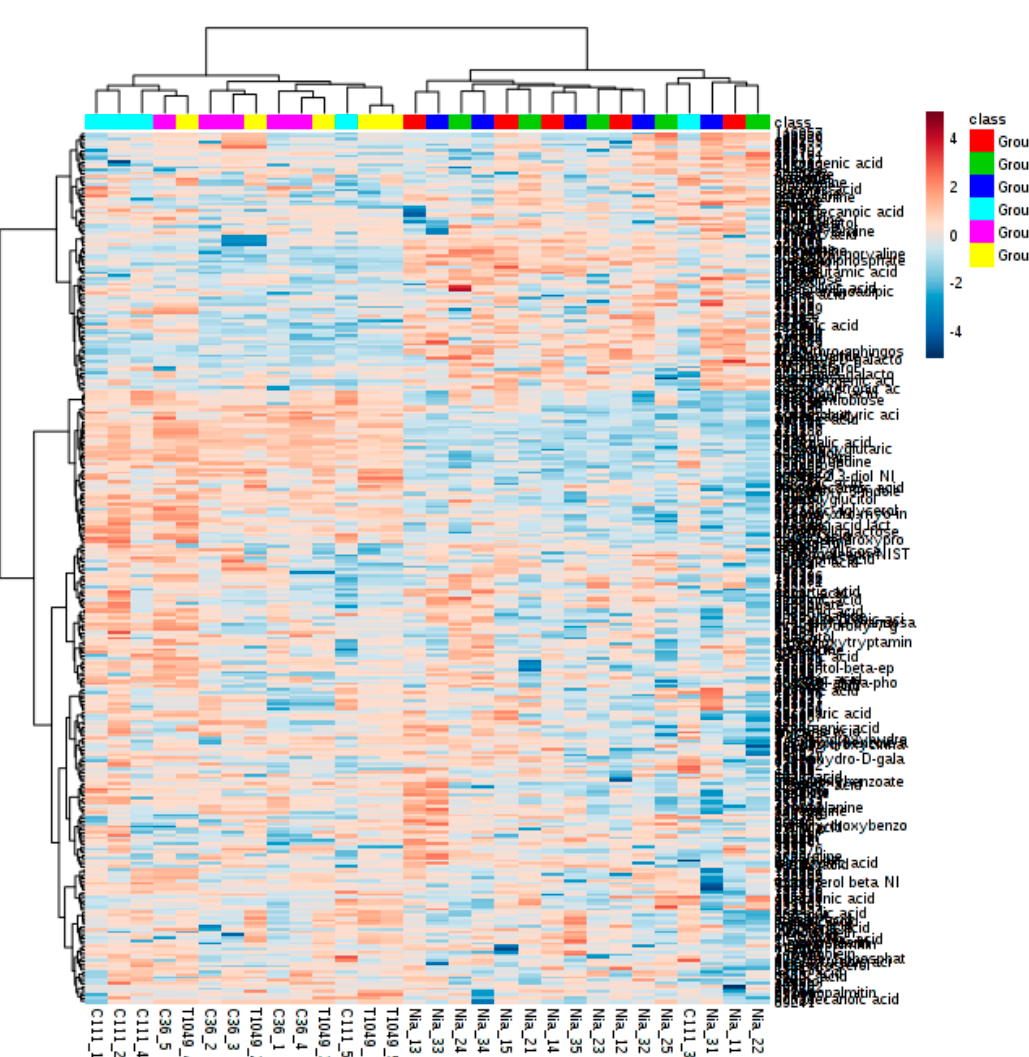
Figure 6. The hierarchical clustering analysis (HCA) showing metabolite diversity and intensity levels in relation to genotypes. Dark brown (4) represents high intensity, while dark blue ( − 4) represents very low intensity. Table 3. Genotypes grouped based on the relative levels of the key metabolites identified from hierarchical analysis (Figure 6).